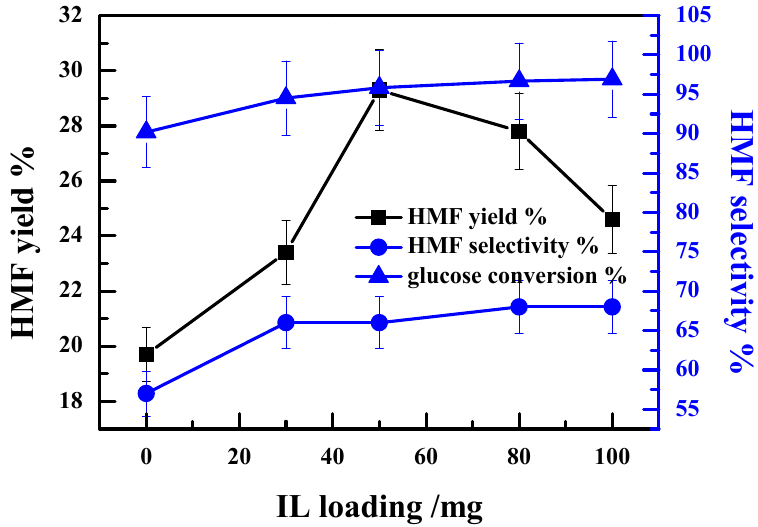
Figure 1. Effect of IL [HO 2 CMMIm]Cl loading on glucose dehydration.Experimental conditions: 0.15 g ZrOCl 2 , 0.1 g glucose, 3.0 g isopropanol, 3 h reaction time, 150 °C reaction temperature.